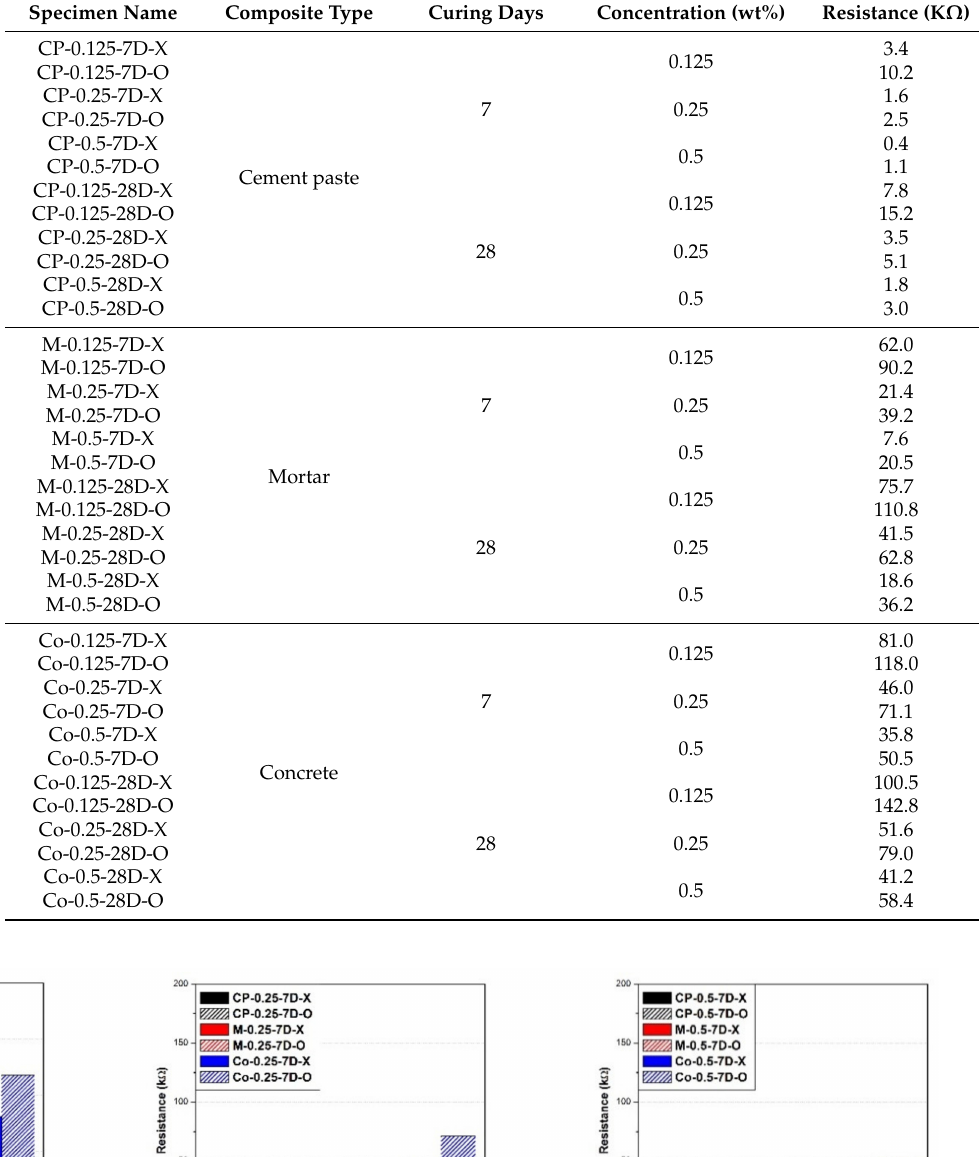
Table 4. Electrical resistance results for the specimens.